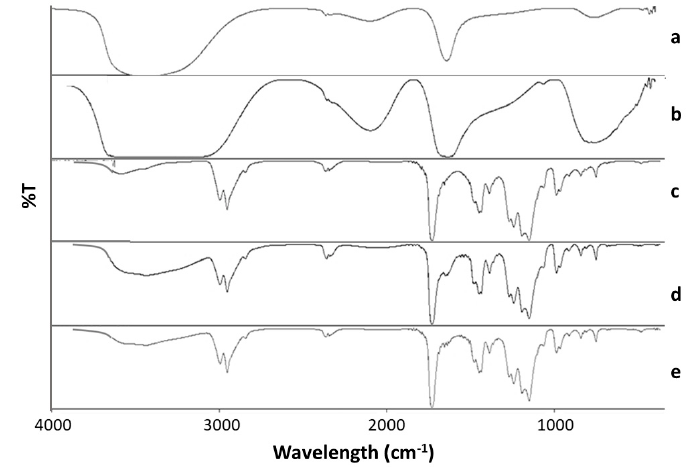
Figure 3. ( a )Atomic Force Microscopy images of PM, PM-C-G, and PM-L-G; ( b ) The bar graph illustrates the surface roughness of nanofiber scaffolds. There was a significant difference in surface